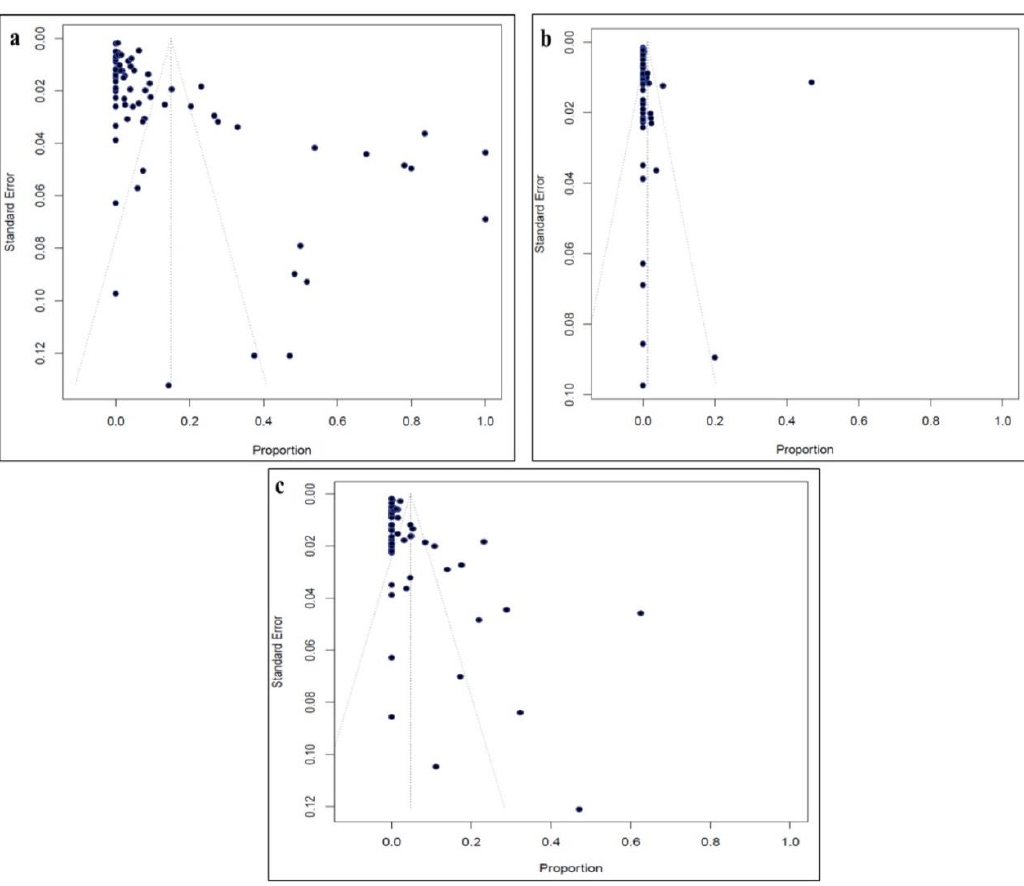
Figure 5. Funnel plots analyzing publication bias among studies evaluated. ( a ) Fluconazole Resistance, ( b ) Amphotericin B Resistance and ( c ) Voriconazole Resistance.